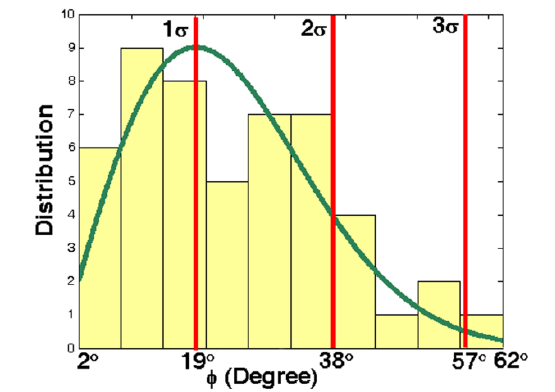
Figure 5. Distribution of angle |φ| for different SC-cut crystals.